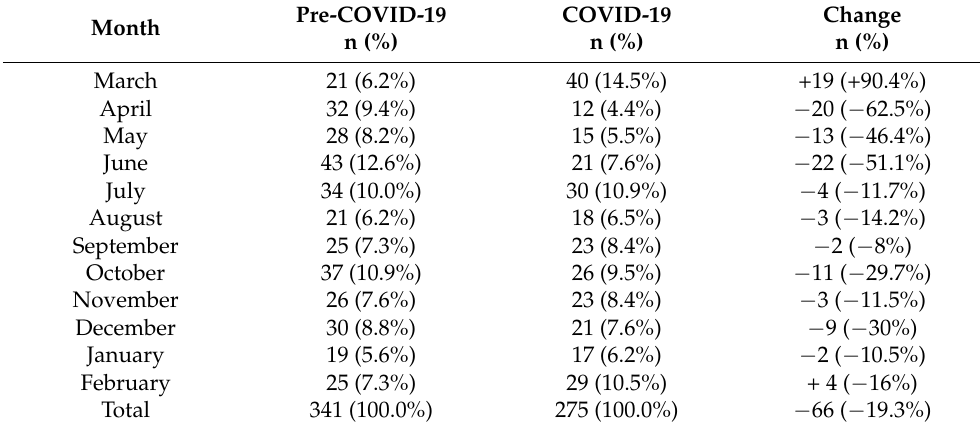
Table 1. Percentage change in melanoma diagnosis by month (March 2019–February 2021).